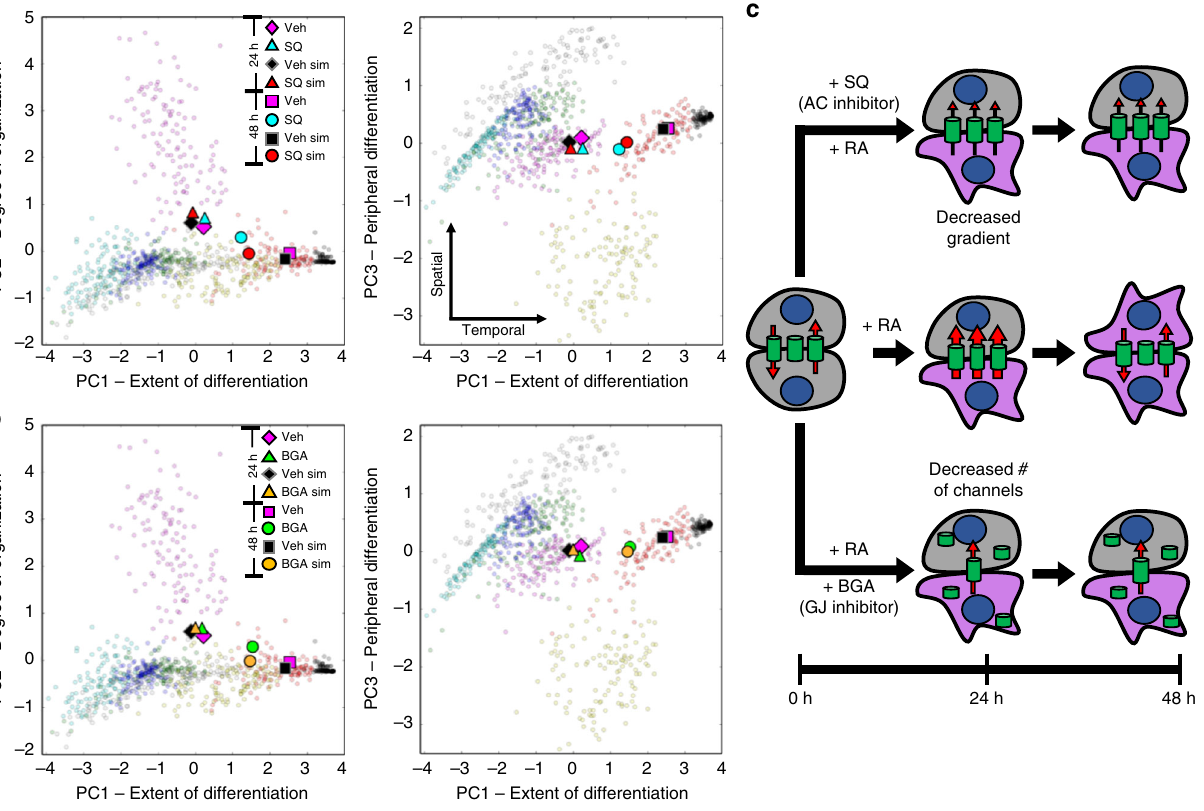
Fig. 6 Perturbation to the intercellular network of a multicellular D3 ESC population affects RA-accelerated differentiation in a temporal manner. At 24 h, neither adenylyl cyclase (AC) inhibition ( a , SQ-treatment) nor gap junction (GJ) inhibition ( b , β -GA-treatment) induced a signi fi cant change in spatial or temporal characteristics of differentiation compared to the vehicle control. By 48 h, a temporal shift along PC1 is observed for both treatments ( a , b ), depicting a decrease in the rate of differentiation. The intercellular model accurately predicted these dynamics, represented by average values for SQ- treatment (Exp: n = 87, Sim: n = 30) and BGA-treatment (Exp: n = 62, Sim: n = 30) compared to the vehicle control (Exp: n = 87, Sim: n = 75) ( a , b ). A schematic diagram of our proposed mechanism for the in fl uence of AC and GJ inhibition on differentiation potential is depicted in c . Speci fi cally, both AC and GJ inhibition are suggested to decrease the intercellular fl ux between cells but via separate mechanisms: modulating the concentration gradient and the number of open channels for AC and GJ inhibition, respectively. Data clouds of a , b before averaging are shown in Supplementary Figures 8,